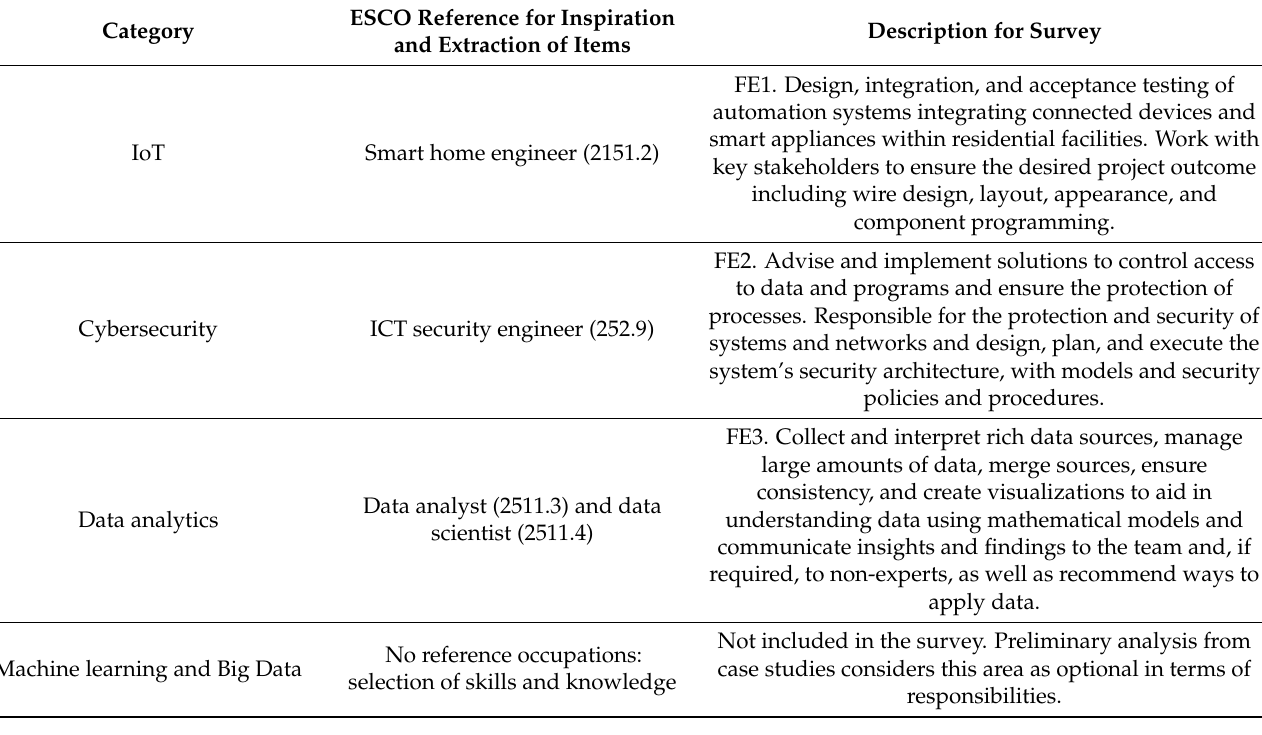
Table 2. Functions for